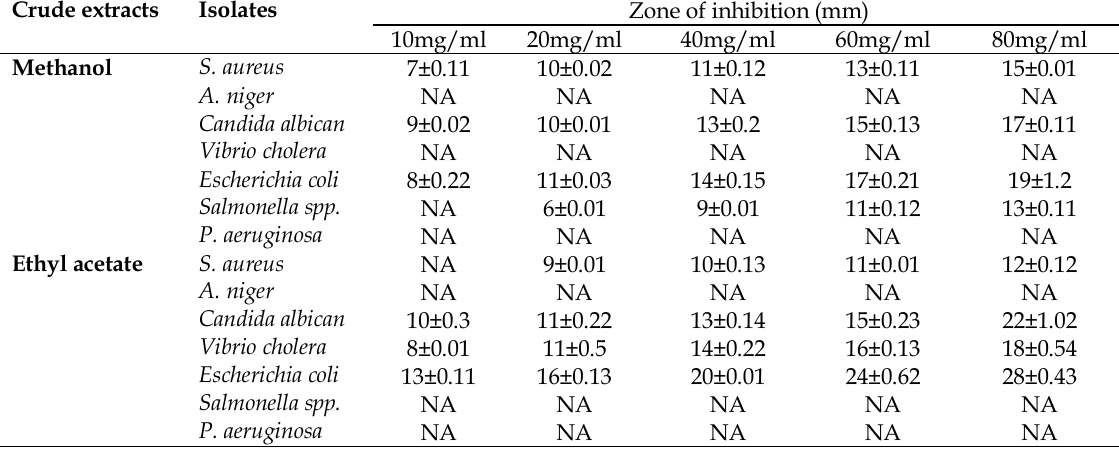
Table 4 : Antimicrobial activity of methanol and ethyl acetate stem extracts of Bryophyllum pinnatum against the human pathogenic bacteria by disc diffusion method. Crude extracts